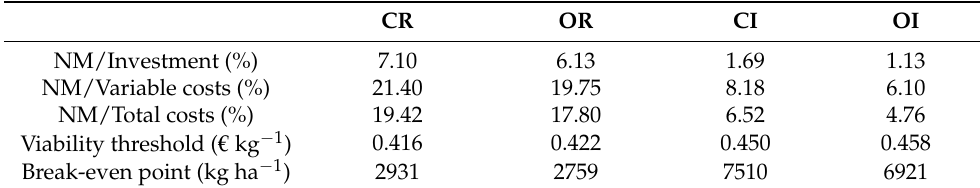
Table 6. Values of the economic indicators for each scenario. CR OR CI OI NM/Investment (%) 7.10 6.13 1.69 1.13 NM/Variable costs (%) 21.40 NM/Total costs (%) Viability threshold ( € kg − 1